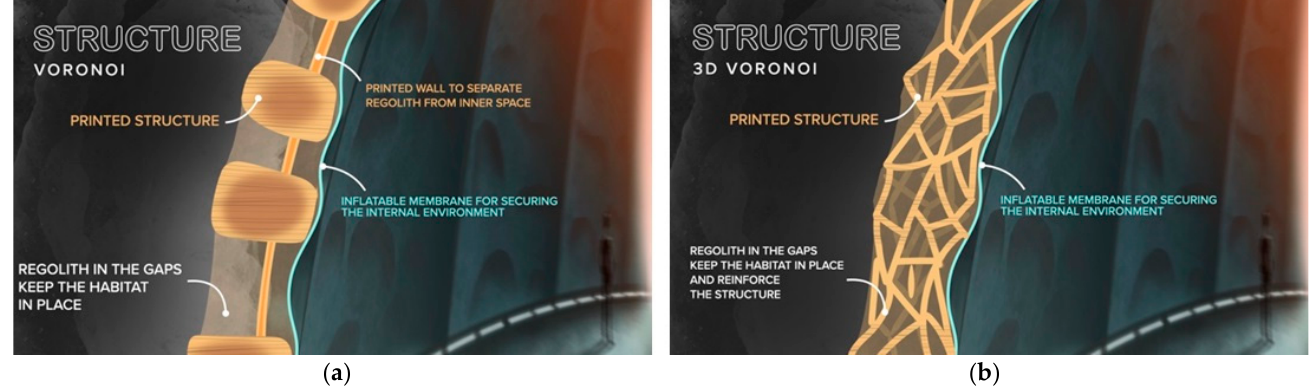
Figure 5. Schematic representation of the use of a Voronoi structure in cross-section view: ( a ) single- layer Voronoi structure with a partition wall, ( b ) 3D Voronoi structure with regolith infill.